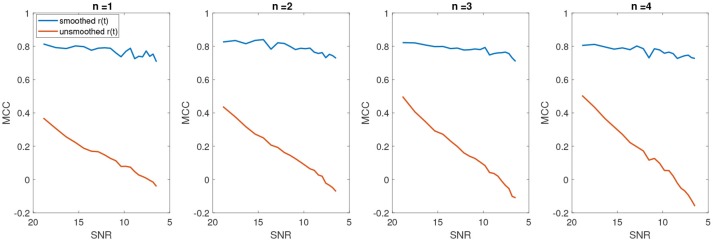
The average Matthews correlation coefficient for different number of SNRs and different number of change points.